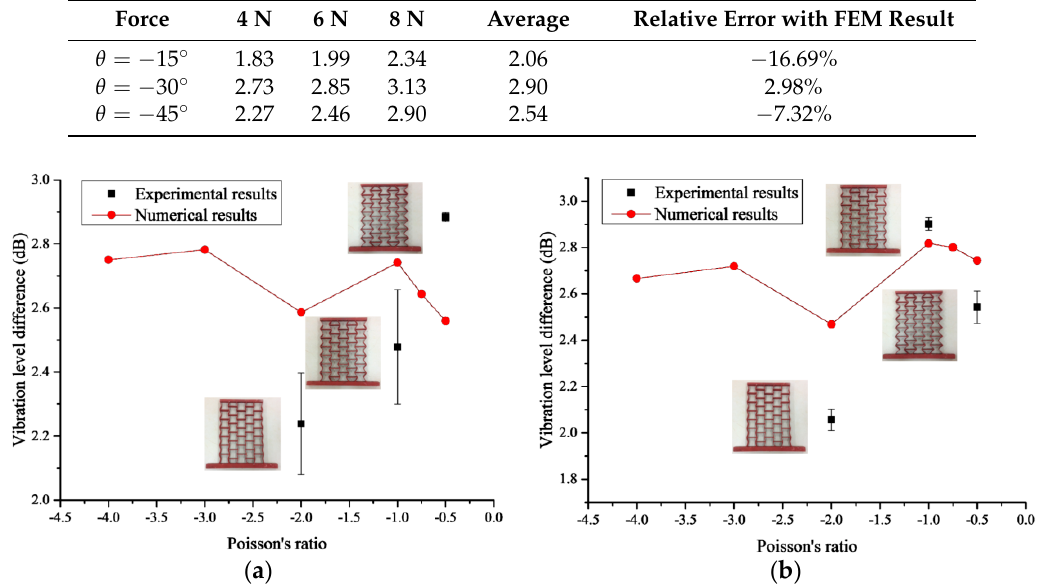
Table 3. Experimental results of the vibration level difference under different exciting forces with the cell thickness t = 2 mm (dB).